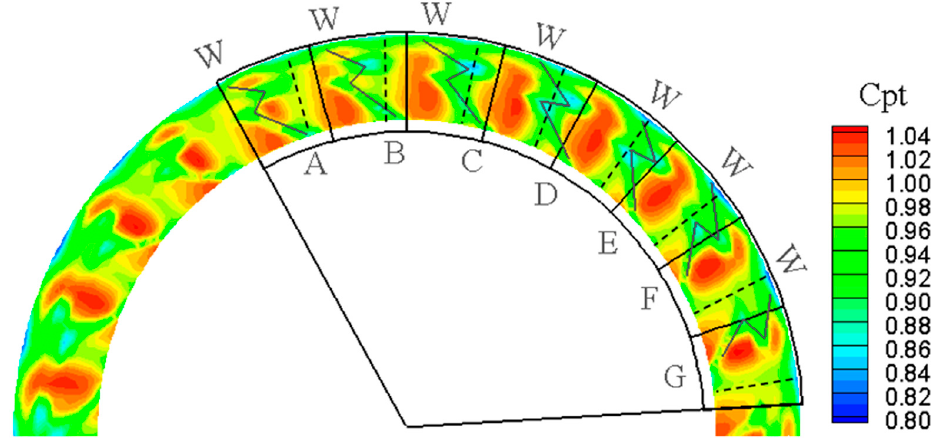
Figure 9. Snapshot of Cpt distribution over multiple channels in different stator–rotor positions. With reference to Figure 9 and starting from left, a low Pt region coincides with black continuous line A, i.e., the stator wake, but another low Pt zone appears on the right (high- lighted with a dashed line), not merged with the former; this second low Pt region is nearly uniform in spanwise direction. As the adjacent channel is considered (wake B), the low Pt zone corresponding to the black line still remains (with marginal difference with respect to the wake A), while the low Pt region ‘moves’ towards the wake and partially overlaps with the latter. For wake C, the two low Pt zones perfectly overlap, leading to the deepest total pressure deficit. Furthermore, shifting from one channel to the adjacent one (wake C to wake D, to E, etc.) the second low Pt region progressively ‘moves’ leftward with respect to the stator wake. The same consideration can be done on the high total pressure region, typically referred to as the isentropic region, where the level is modulated passing from one channel to the adjacent one. The time average of this process in the ab- solute frame, which is the average among the different stator channels appearing in this plot, has been already reported in Figure 4. Moreover, if the pressure level is considered, the time-averaged value Pt in the free stream is 1.345 bar (which corresponds to the up- stream one), while the phase resolved one is up to 1.36 bar. Since across the stator the total pressure cannot increase, the azimuthal perturbation of Pt discussed above is clearly an effect of the rotor on the flow released by the stator. As a further proof of that, this Pt perturbation rotates consistently with the sweeping of the rotor blades. In fact, as the rotor sweeps downstream of the stator outlet section, the rotor potential field propagates upstream with a wave of high and low static pressure, which also induces corresponding changes in the local flow direction. This also induces a local redistribution of mechanical energy, conceptually corresponding to an ‘internal’ work exchange between different portions of the flow, which ultimately alters the total pressure. In Section 5 a quantification of the periodic change in total temperature on the fluid upstream of the rotor, resulting from the process discussed above, will be proposed. Considering the absolute flow angle, reported in Figure 10, the rotor-induced pertur- bation is observed to alter the flow direction. In particular, the interaction positions la- belled as wake C and D show the maximum over-turning (high angles) in the midspan region and the maximum under-turning (low angles) condition at hub. The maximum cross flow at the tip is for the interaction position E, F, where also the lowest total pressure is found. The Mach number field, reported in Figure 11, shows a modulation among the adjacent channels. This feature evidences that changes in the flow rate released by the stator channel depend on the rotor position, as the blade leading edge creates a blockage at the outlet of the stator channel. The lowest Mach number, as an average on the passage, is found in the channel between wakes D and E.